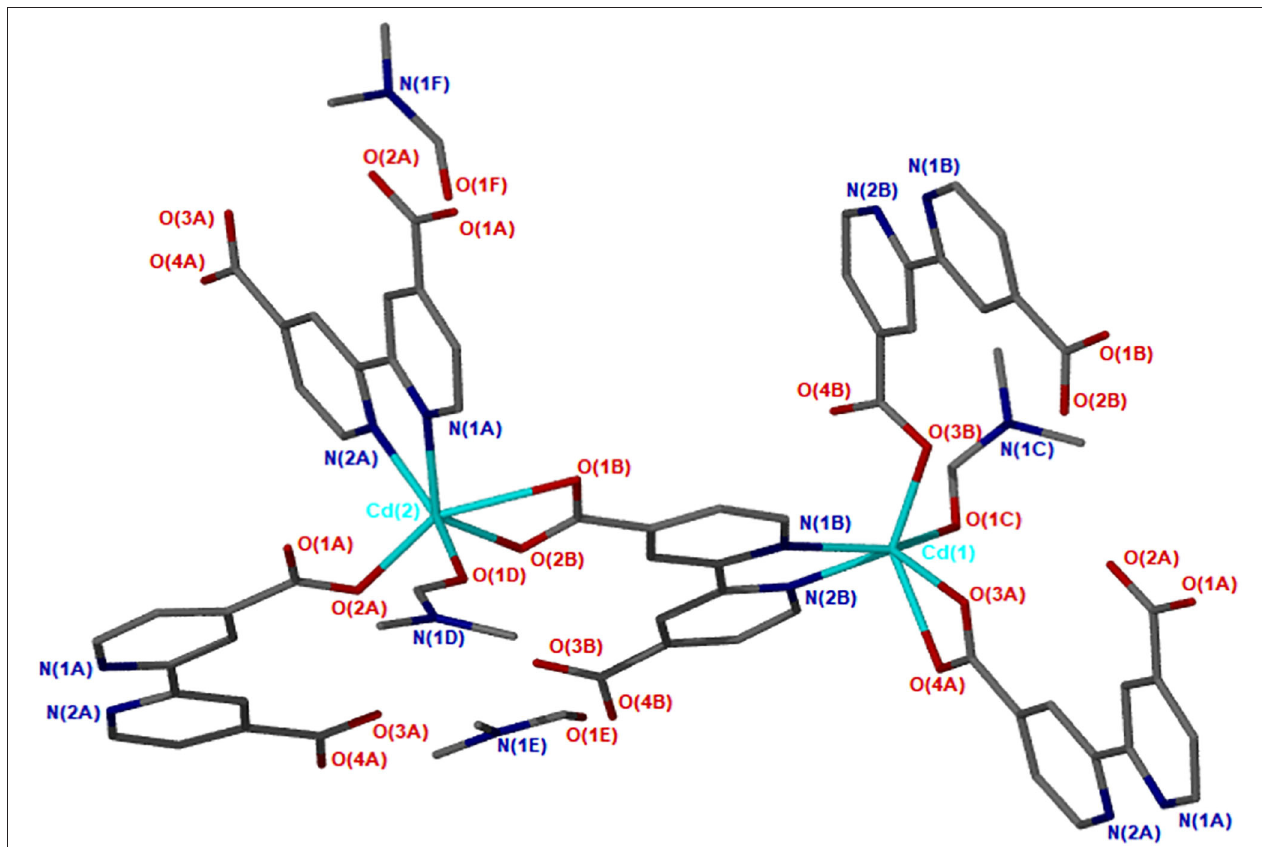
FIGURE 1 | Coordination environment of Cd(II) in